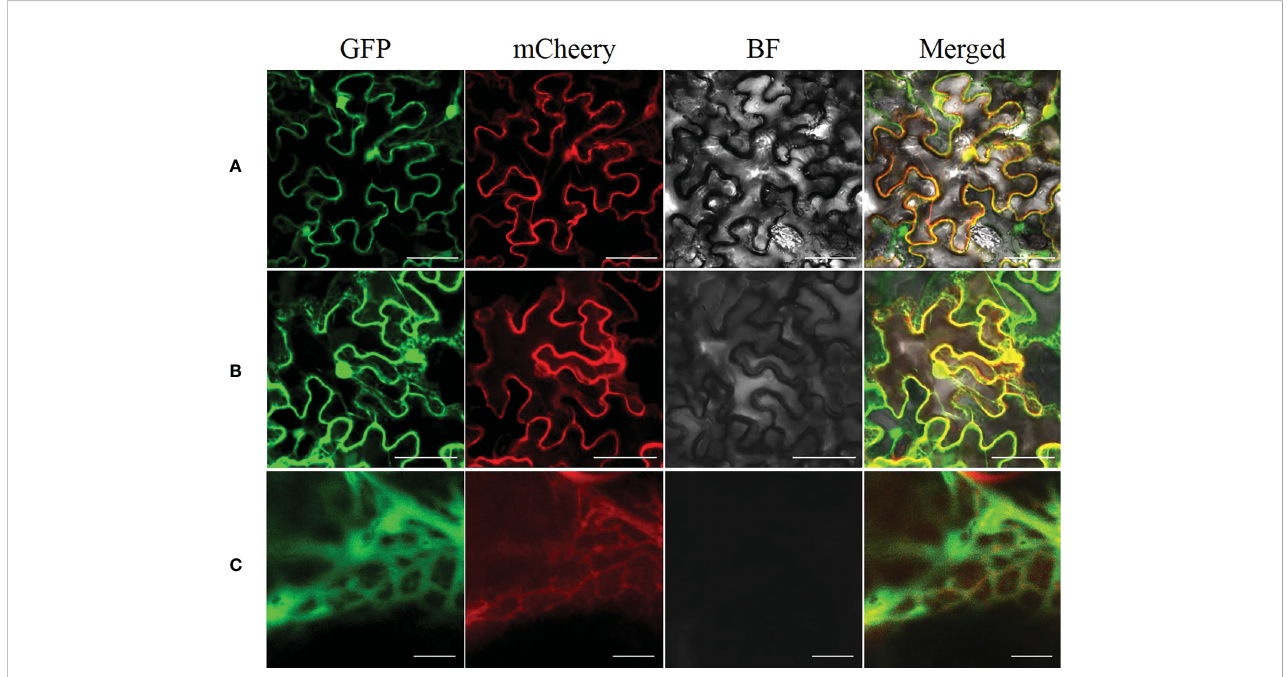
FIGURE 5 Subcellular localization of AhGPAT9 in tobacco leaves. (A) Representative laser-scanning images of tobacco mesophyll cells co-expressing EGFP and mCherry empty vectors (bars = 50 mm). (B) Representative laser-scanning images of tobacco mesophyll cells co-expressing AhGPAT9-EGFP and